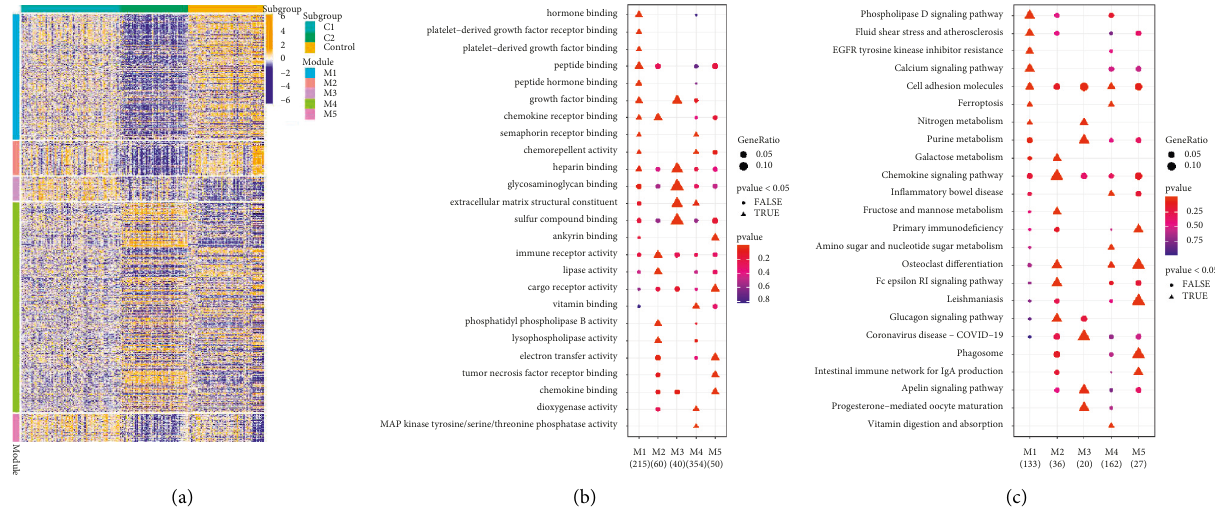
Figure 4: Molecular characterization of the molecular subgroups. (a) Expression heat map of five weighted gene co-expression network analysis modules. (b) GO analysis of 5 modules. (c) KEGG analysis of 5